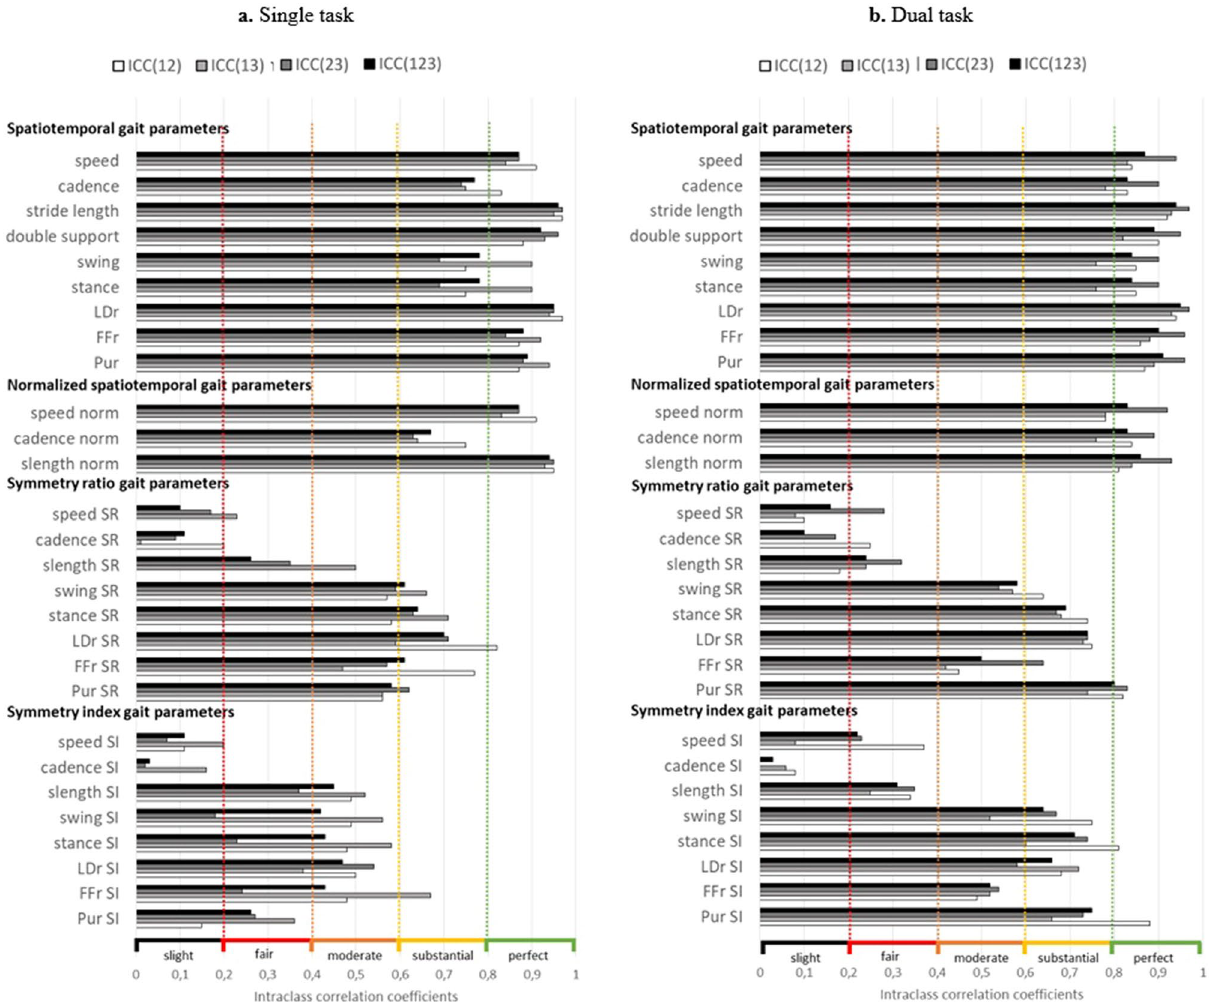
Figure 1. Intraclass correlation coefficients calculated with the means of trial 1–2, 1–3, 2–3 and 1–2-3 in single-task ( a ) and dual-task ( b ) conditions; Dotted color lines correspond to relative reliability thresholds with: slight (black: 0.00 < ICC < 0.2), fair (red: 0.21 < ICC < 0.4), moderate (orange: 0.41 < ICC < 0.6), substantial (yellow: 0.61 < ICC < 0.8), and almost perfect (green: 0.81 < ICC < 1.0) reliability 49 . Abbreviations: LDr = Load Ratio, FFr = Foot Flat ratio, PUr = Push ratio, nprm = normalized, SI = symmetry index, SR = symmetry ratio, slength = stride